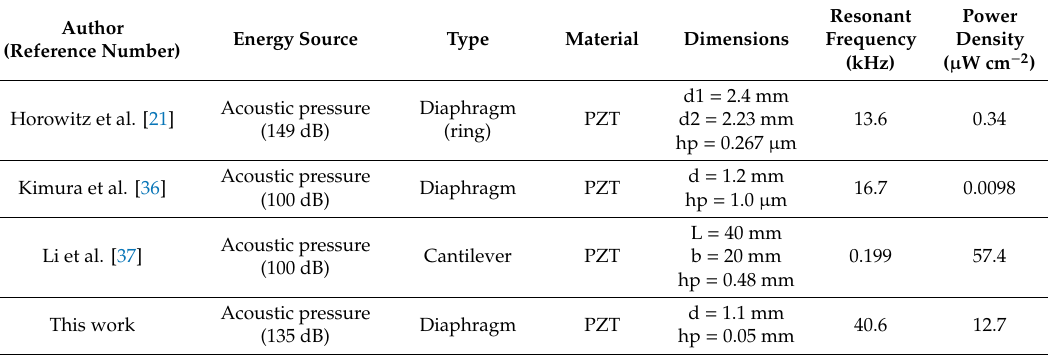
Table 4. Comparison of acoustic energy harvesters based on resonator